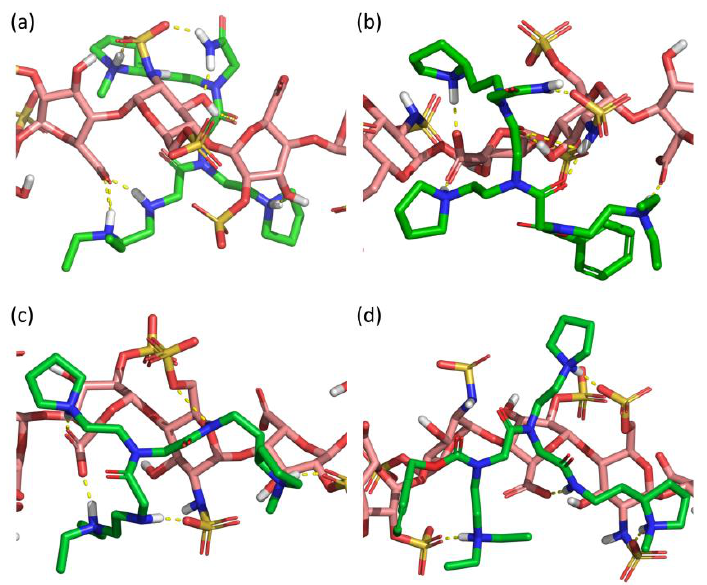
Figure 7. Best docked poses of ( a ) SICHI, ( b ) CSIC02, ( c ) CSIC03 and ( d ) CSIC04 to a dp8 heparin model.